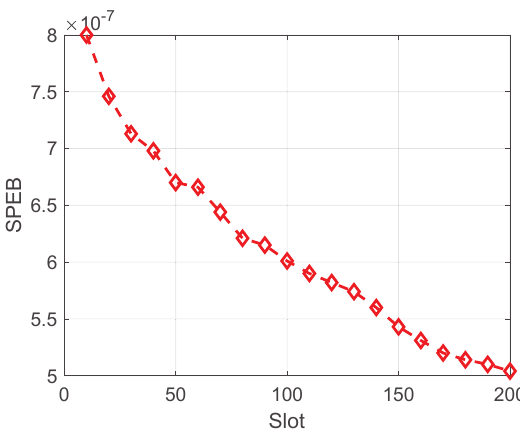
Figure 6. Sequential estimation.